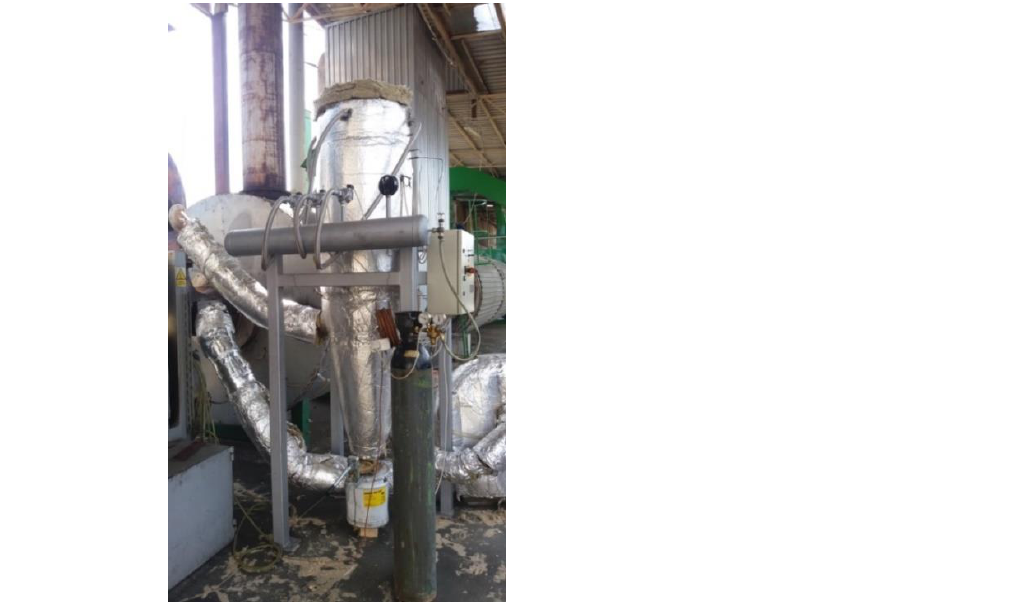
Figure 3. A view of the ceramic filter installed in the tested installation.